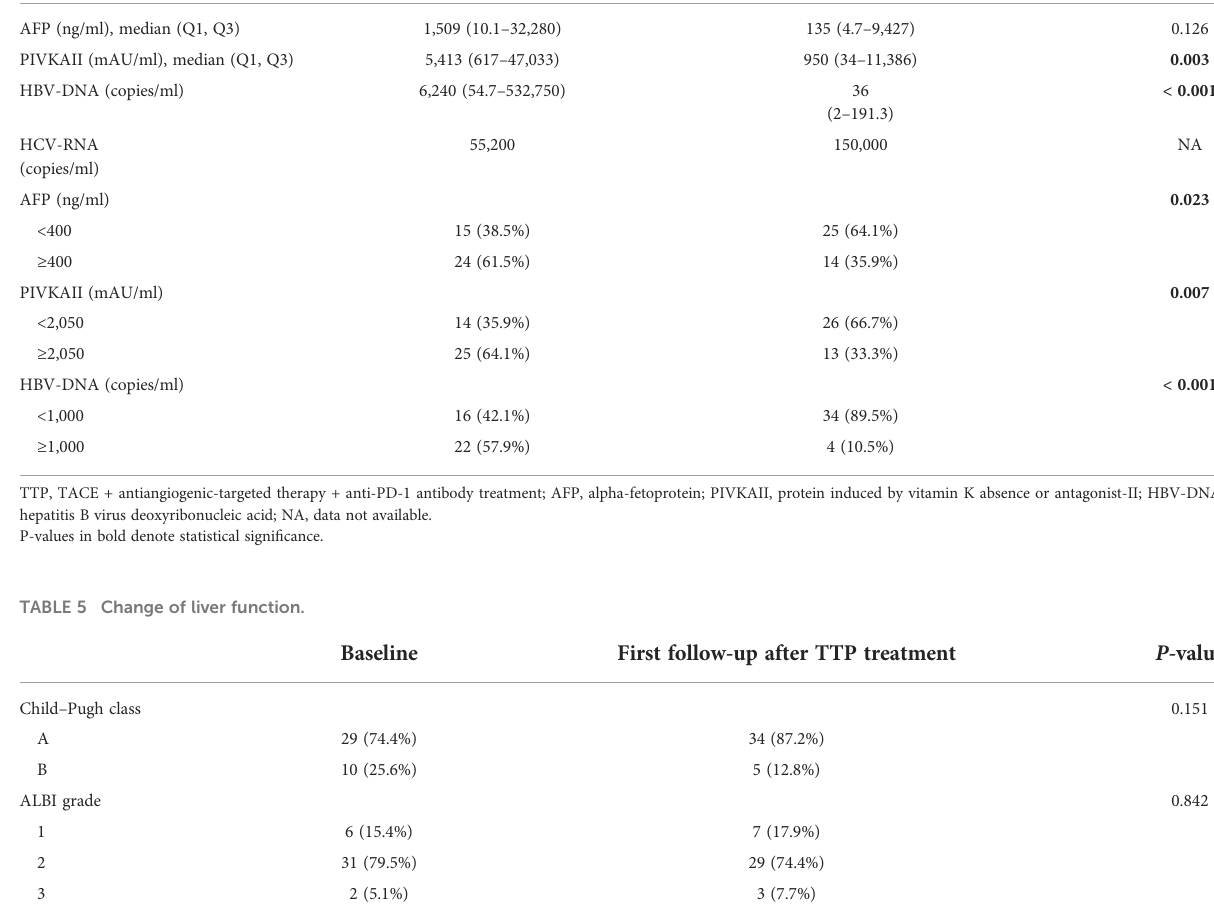
concurrent HVTT/IVCTT, (III) the tumor number, and (IV) tumor size are illustrated in Figure 4. As shown in Figure S1, TABLE 6 Additional treatments aside from TACE + antiangiogenic patients who received additional treatments (radiotherapy, targeted therapy + anti-PD-1 antibody treatment. percutaneous microwave coagulation therapy, or T+A) had All patients signi fi cantly better OS than those who did not ( P = 0.046, Figure S1A). The PFS of patients who underwent additional treatments was also better compared with that of patients who did not but without statistical signi fi cance ( P = 0.14, Figure S1B). The results of the univariate analysis of OS and PFS are displayed in Table S1. The association between the different cycles of TTP therapy and liver function and tumor marker expression change can be seen in Figure S2.